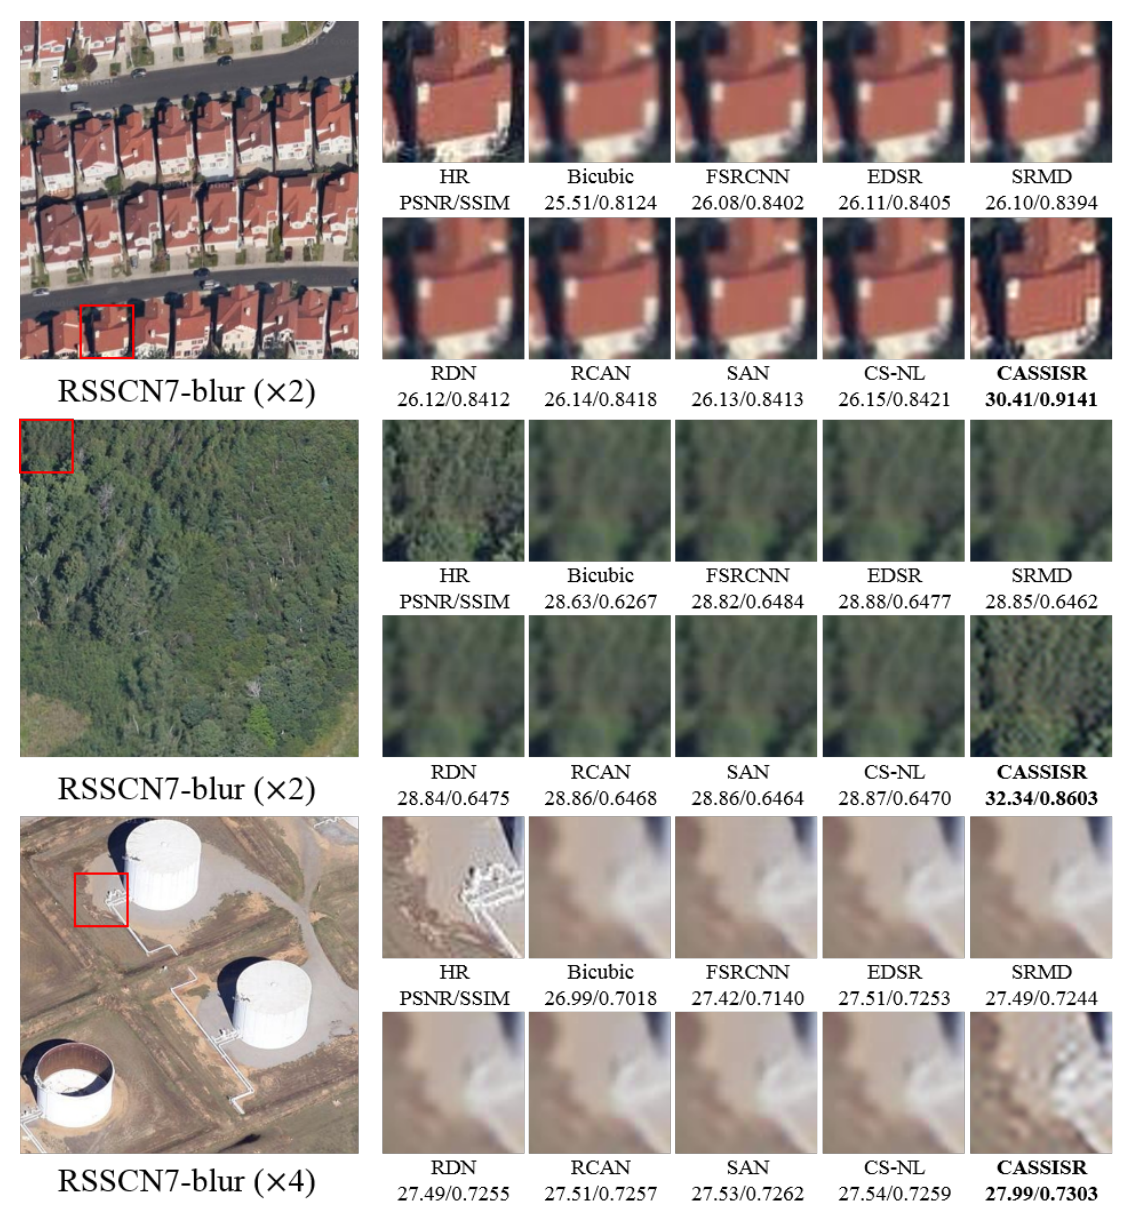
Figure 4. Qualitative comparison of scaling factors × 2 and × 4 between CASSISR and CNN-based SR methods on RSSCN7- blur dataset. Our CASSISR results are highlighted